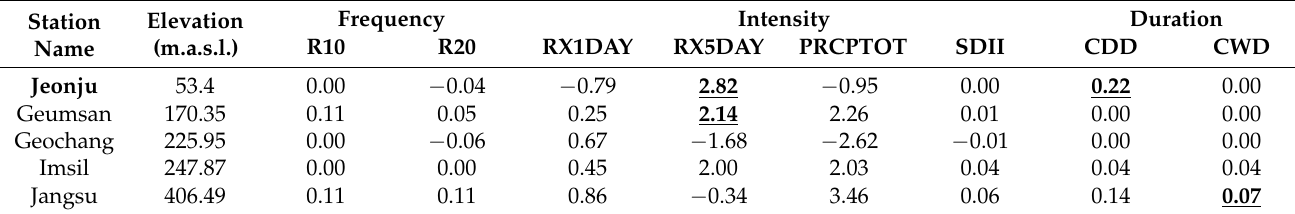
Table A2. Summary of annual trend magnitudes of the precipitation indices in the UGRB for 33 years (1998–2020). Station Geumsan